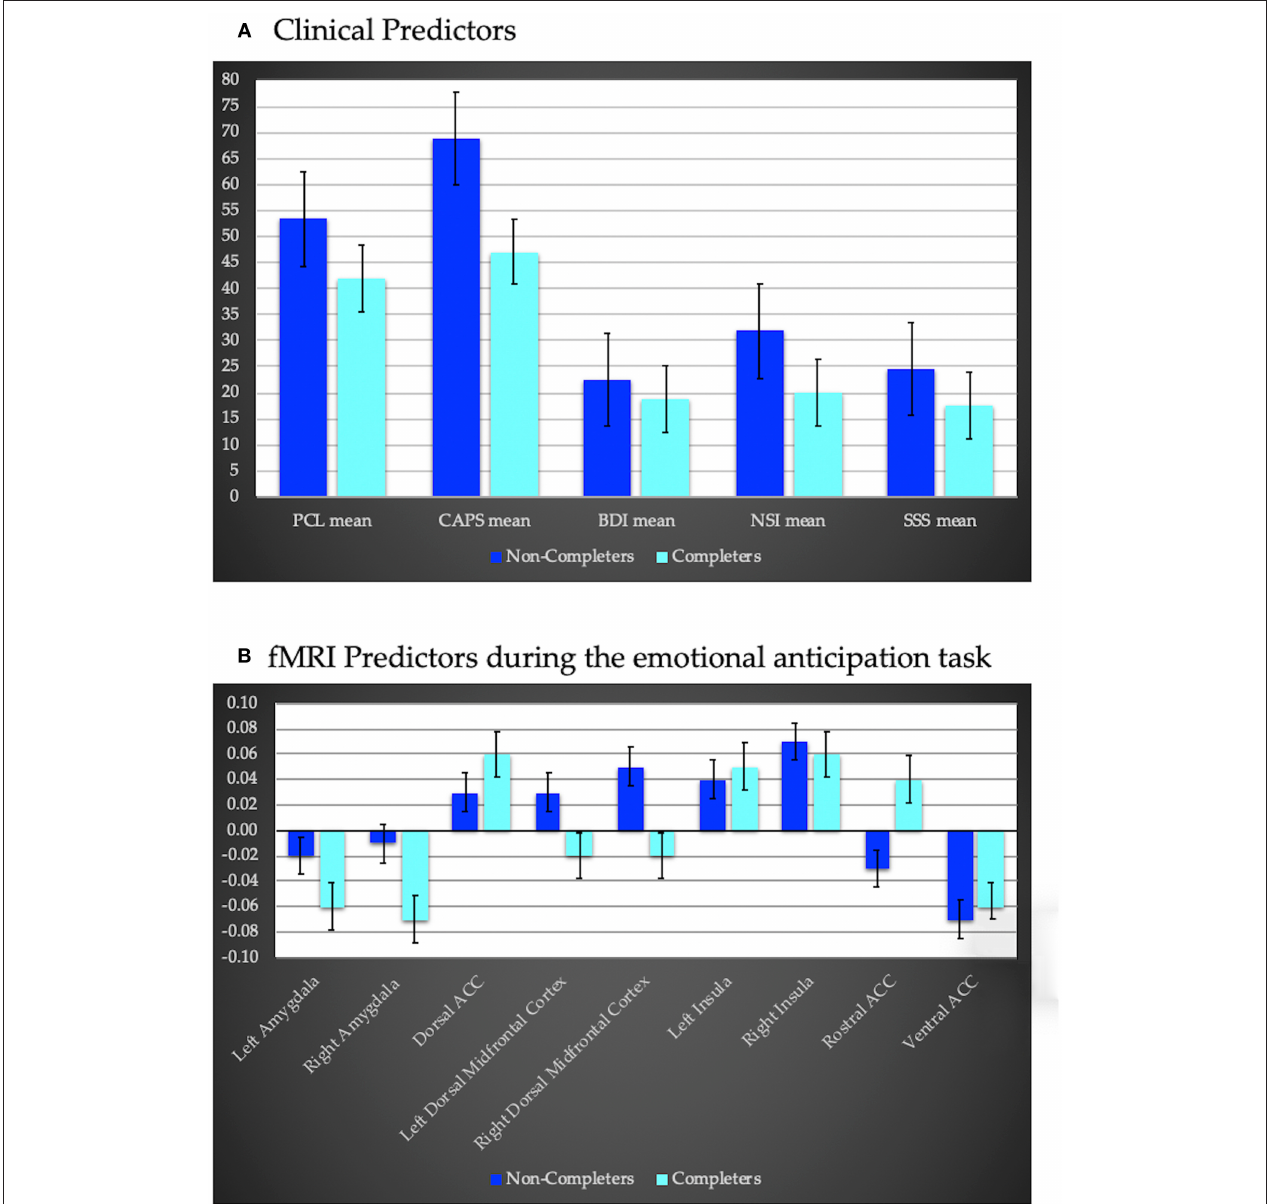
FIGURE 2 | (A) clinical predictors of treatment completion including PTSD severity using the PTSD Symptom Checklist (PCL), and the Clinician Administered PTSD Scale (CAPS), depression severity assessed via the Beck Depression Inventory (BDI)—II, the Neurobehavioral Symptom Inventory (NSI) to assess sequelae of traumatic brain injury, and the Sensation Seeking Scale (SSS) to assess impulsivity. Completers exhibited less severe symptoms compared to non-completers. (B) fMRI predictors of treatment completion during an anticipation task (negative–positive affective trials). Regions of interest include bilateral amygdala, insula and dorsal midfrontal cortex, as well as dorsal, ventral, and rostral anterior cingulate cortex (ACC). Completers displayed hypoactivation within bilateral amygdala, and dorsal midfrontal cortex and hyperactivity within the rostral and dorsal ACC and left insula relative to